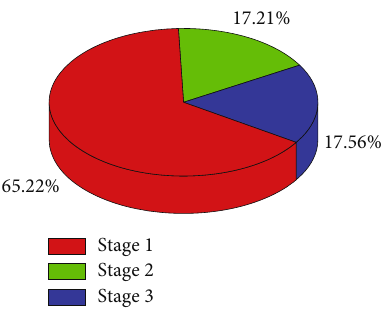
Figure 9: Axial force increment proportion in di ff erent construction stages of the pile foundation